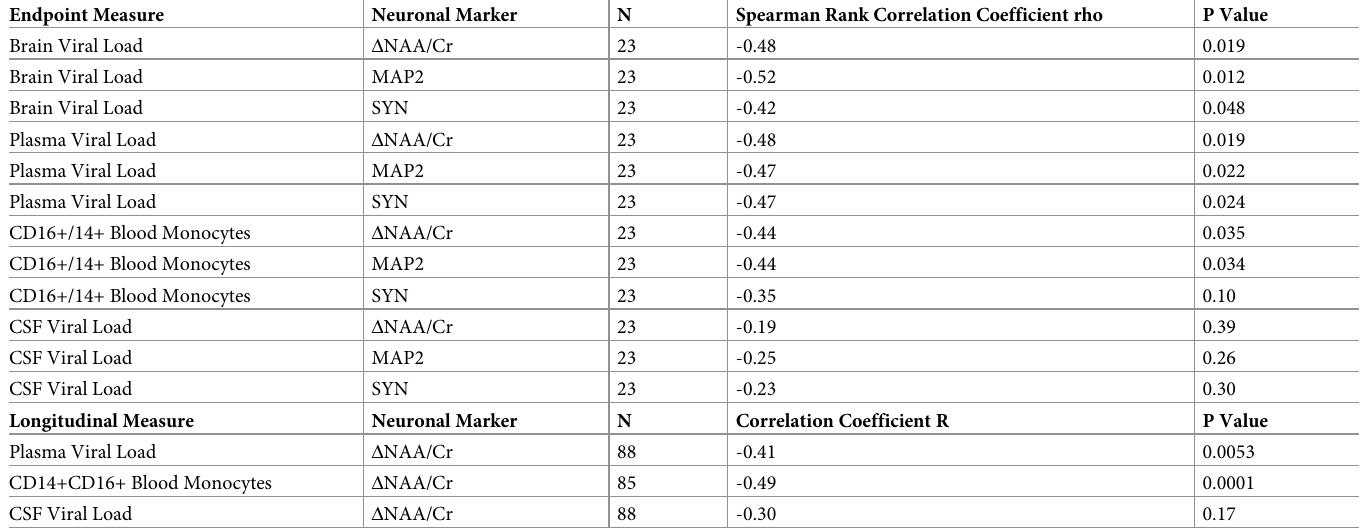
Understanding the relationship between the severity of neuronal injury and the amount of virus in all three compartments may explain the viral entry into the CNS and the subsequent fate of the virus. In our study, the severity of neuronal injury was reflected by declines of neu- ronal biomarkers which correlated with the amount of virus in the brain and plasma. The severity of neuronal injury also correlated with the number of activated CD14 + /CD16 + mono- cytes, but not with the CSF viral load ( Table 3 ). At endpoints, significant inverse correlations were found between all three neuronal biomarkers (NAA/Cr, MAP2, SYN) and viral levels in both brain and plasma (S2 Fig ), indicating more severe neuronal injury with higher viral levels in plasma and brain compartments. In addition, endpoint levels of CD14 + /CD16 + monocytes significantly inversely correlated with NAA/Cr and MAP2 levels. Inverse correlation between endpoint CD14 + /CD16 + monocyte levels and SYN levels trended toward statistical signifi- cance. CSF viral loads had no significant correlation with any of the neuronal markers at endpoint. Table 3. Correlations between viral load and neuronal